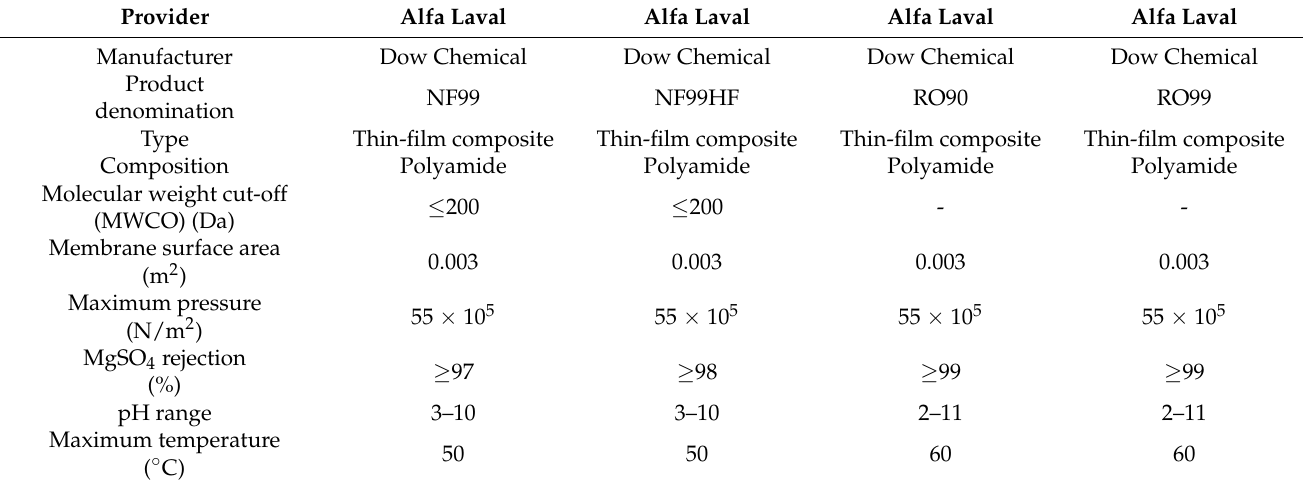
Table 1. Main characteristics of the NF and RO membranes